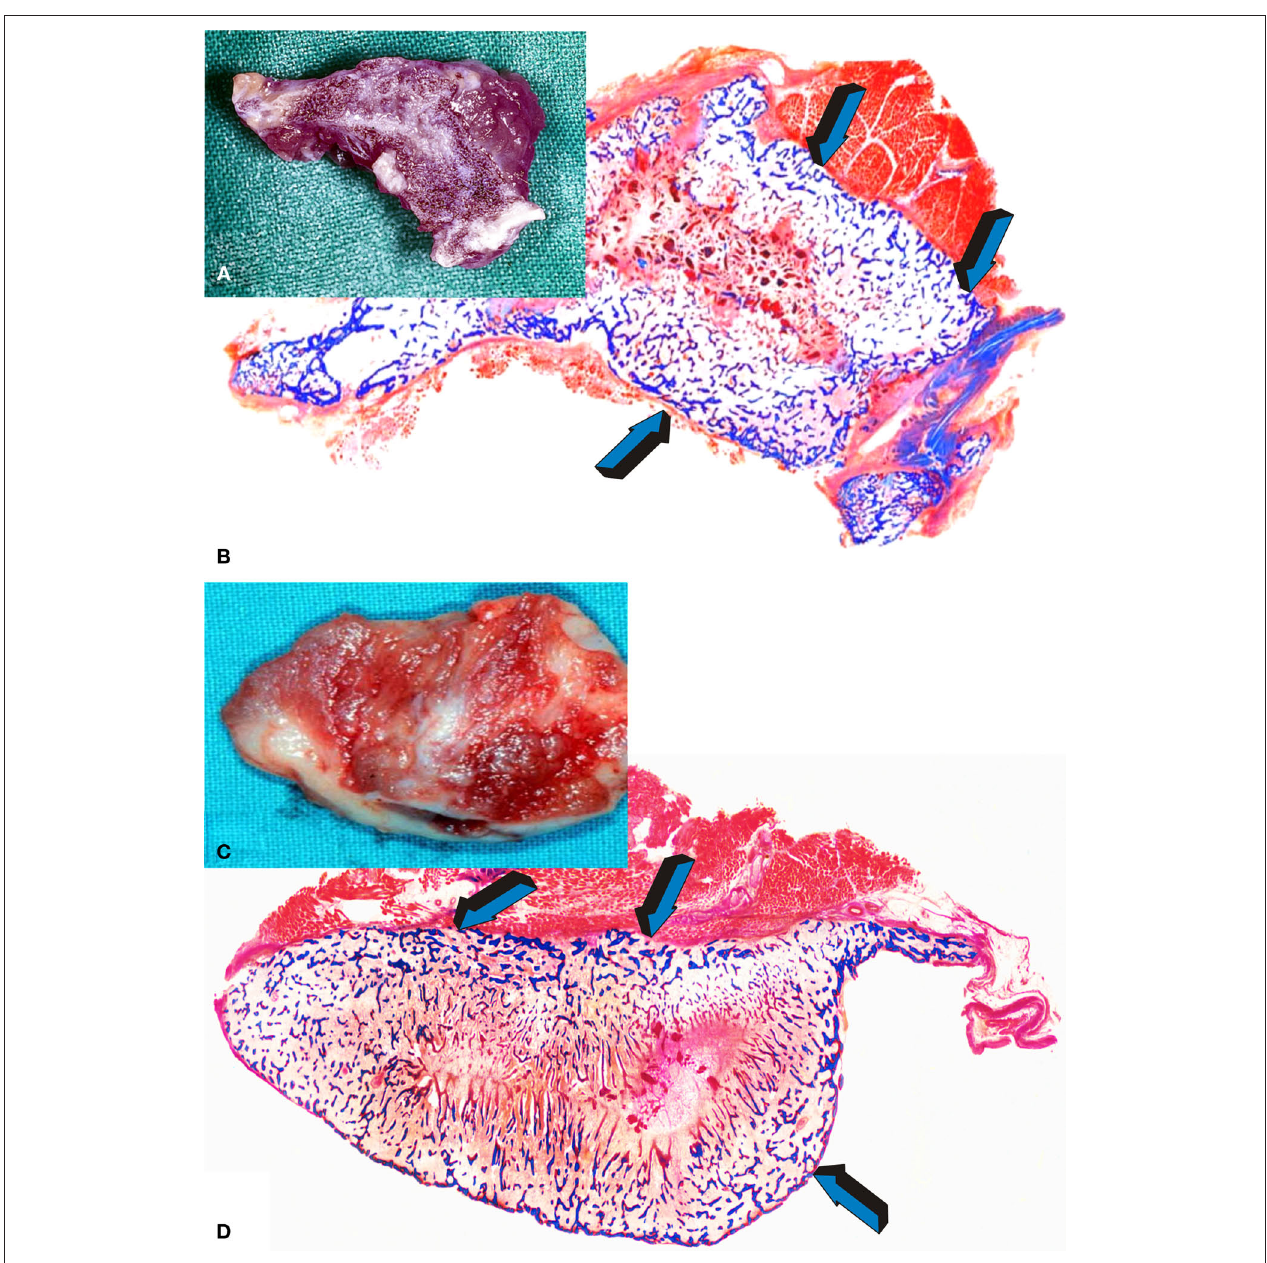
Figure 2 | Tissue induction and morphogenesis of large and corticalized ossicles (A,C) upon implantation of 125 μg hTGF- β Rectus Abdominis muscles of adult baboons Papio ursinus harvested on day 90 after heterotopic implantation; (B,D) undecalcified low power view